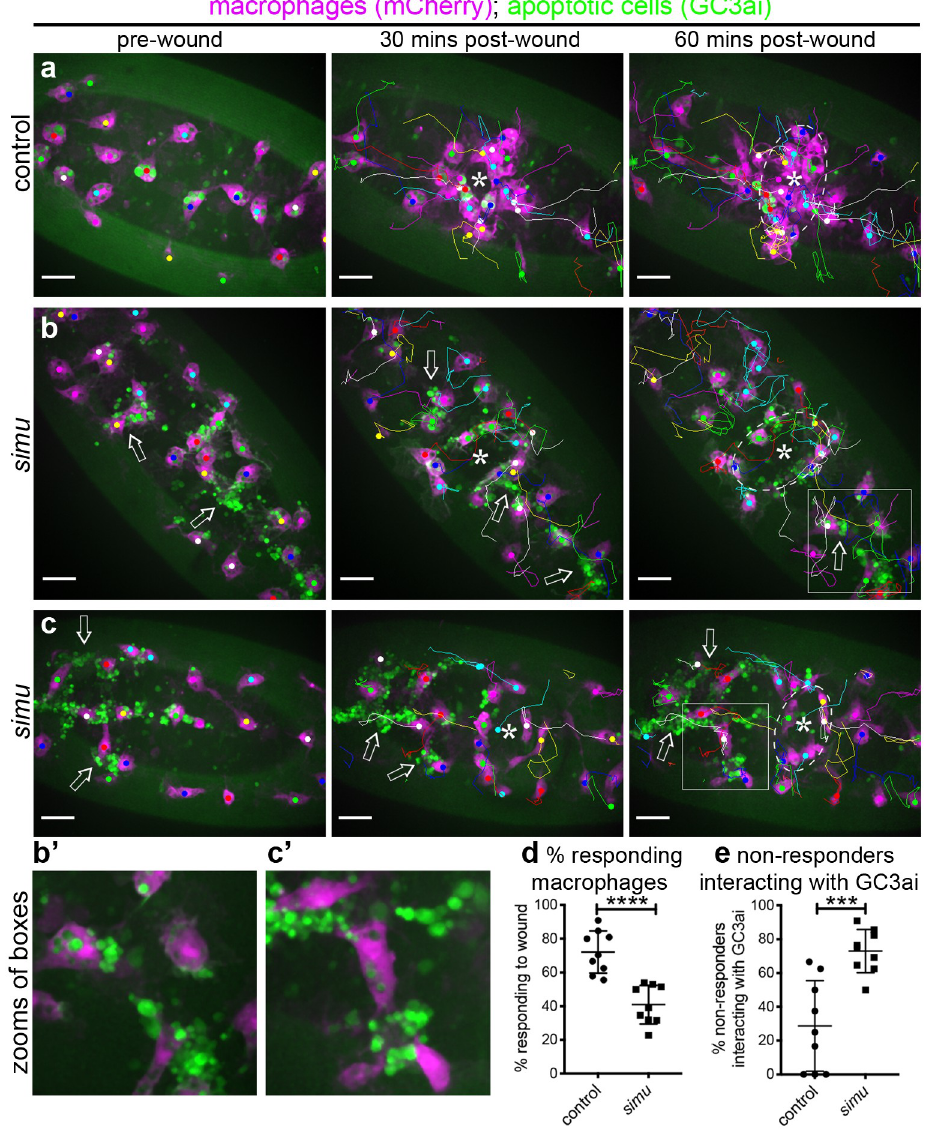
Fig 7. Macrophages that fail to respond to wounds in simu mutants interact with uncleared apoptotic cells. (a–c) Ventral projections of the midline region and associated tracks of macrophages (mCherry, purple) migrating to wounds in control (a) and simu mutant embryos (b–c) in the presence of the caspase reporter GC3ai (green) to label apoptotic cells/fragments at the indicated times. Asterisks show centre of wound and dotted white lines show wound edges at 60 minutes; arrows indicate examples of regions in which interactions between GC3ai punctae and macrophages occur, disrupting wound responses. (b’–c’) Show zooms and single-channel images of the boxed regions in (b–c). (d–e) Percentage of cells responding to wounding (d) and proportions of nonresponding cells that interact with GC3ai punctae (e) in control and simu mutant embryos ( n = 9 for each genotype, P < 0.0001 [d] and P = 0.0007 [e], via Mann–Whitney test). All genotypes are w;;da-GAL4 , UAS-GC3ai/srp-3x-mCherry (control) or w;simu 2 ; da- GAL4 , UAS-GC3ai/srp-3x-mCherry ( simu ). N.b., images have not been rotated in order to provide a larger field of view to visualise a greater number of macrophage–apoptotic cell interactions; scale bars represent 20 μ m; lines and error bars on (d–e) show mean and standard deviation; ��� and ���� denote P < 0.001 and P < 0.0001. All data used to plot graphs may be found in Supporting information file S1 Data. UAS, upstream activating